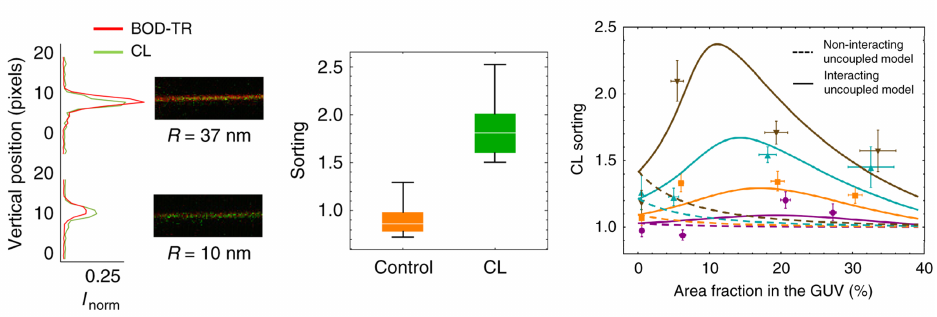
Figure 8. ( Left ) Images and intensity profiles of tubes pulled from GUVs containing CL for large (R ≈ 37 nm) and small (R ≈ 10 nm) tube radii. ( Middle ) Box plots comparing the sorting ratio for curved tubes pulled from GUVs containing green fluorescent lipids. CL is enriched in the tubes comparing with the lipid control. ( Right ) CL enrichment as a function of CL density in GUVs for four ranges of tube curvature. Dashed and solid lines represent respectively the minimum square fit to the non-interacting and interacting uncoupled model (no or possible CL-CL interactions). Reproduced with permission from Beltrán-Heredia et al. [80], Commun. Biol.; published by Nature Publishing Group,